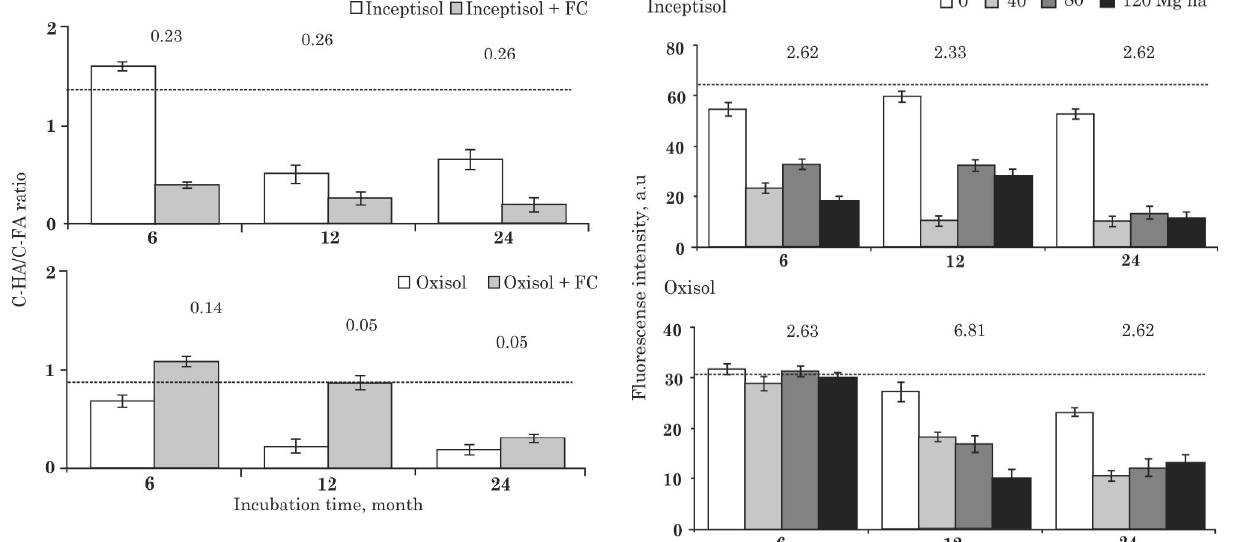
Figure 4. Effect of filter cake compost on C-HA/ C-FA ratio. Error bars represent the standard error of the mean. White bars represent soil without compost application and gray bars represent the average of all three doses of FC compost application. Horizontal dashed line represents values for untreated soil evaluated at the beginning of the experiment. Numbers refer to least significant difference (Tukey test, p < 0.05).